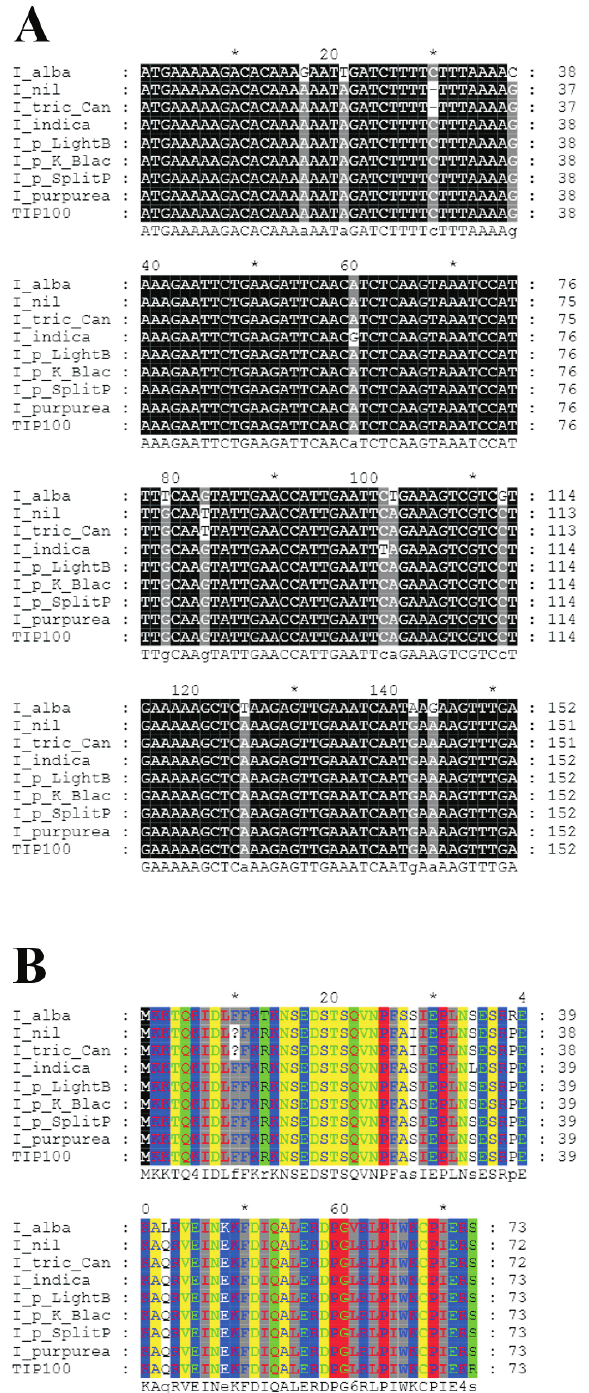
Figure S1 - Multiple alignment of the 5’ end of the Tip100 transposase CDS. (A) Nucleotide sequences in the different species and varieties analyzed in this study. (B) Protein sequences of the first 73 residues of the Tip100 transposase coding sequence. Colors show the physiochemical properties of the amino